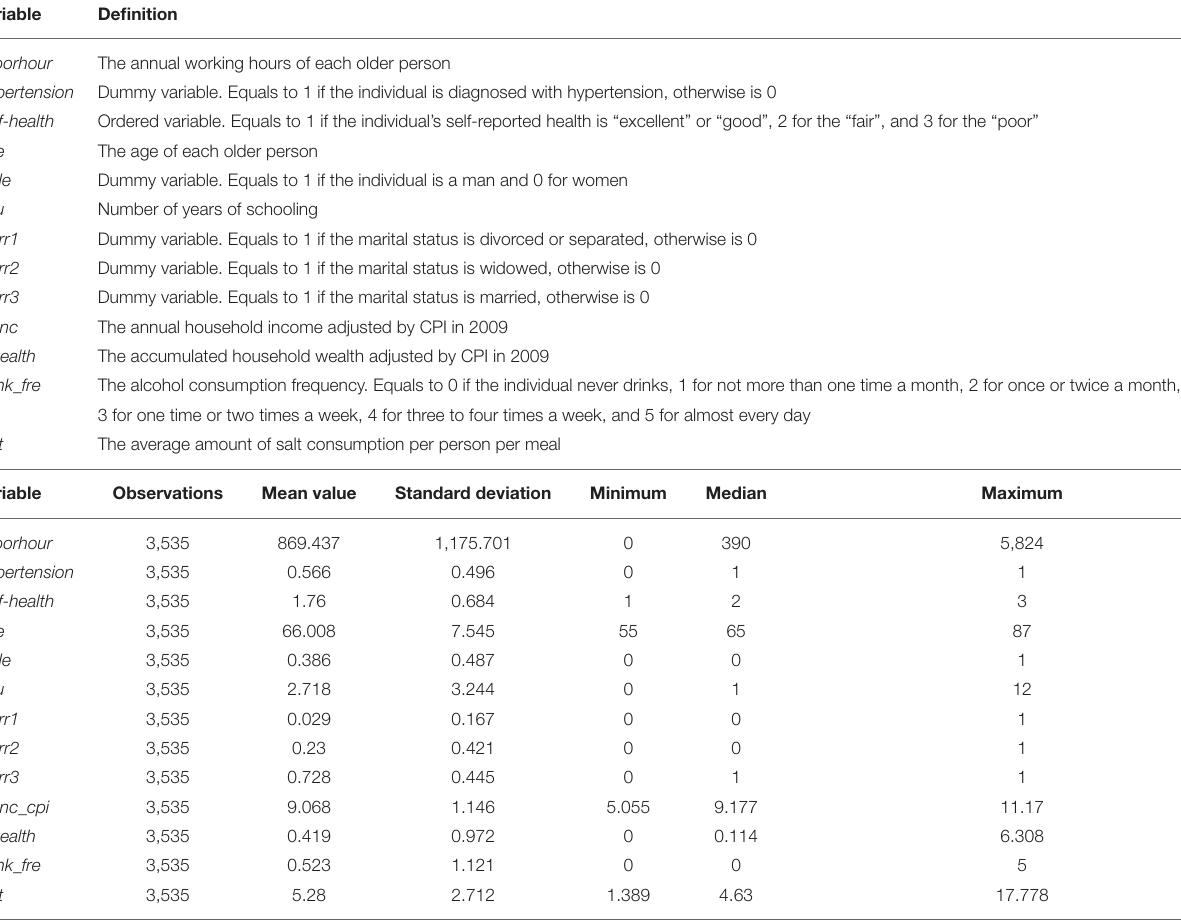
TABLE 1 | Descriptive statistics.